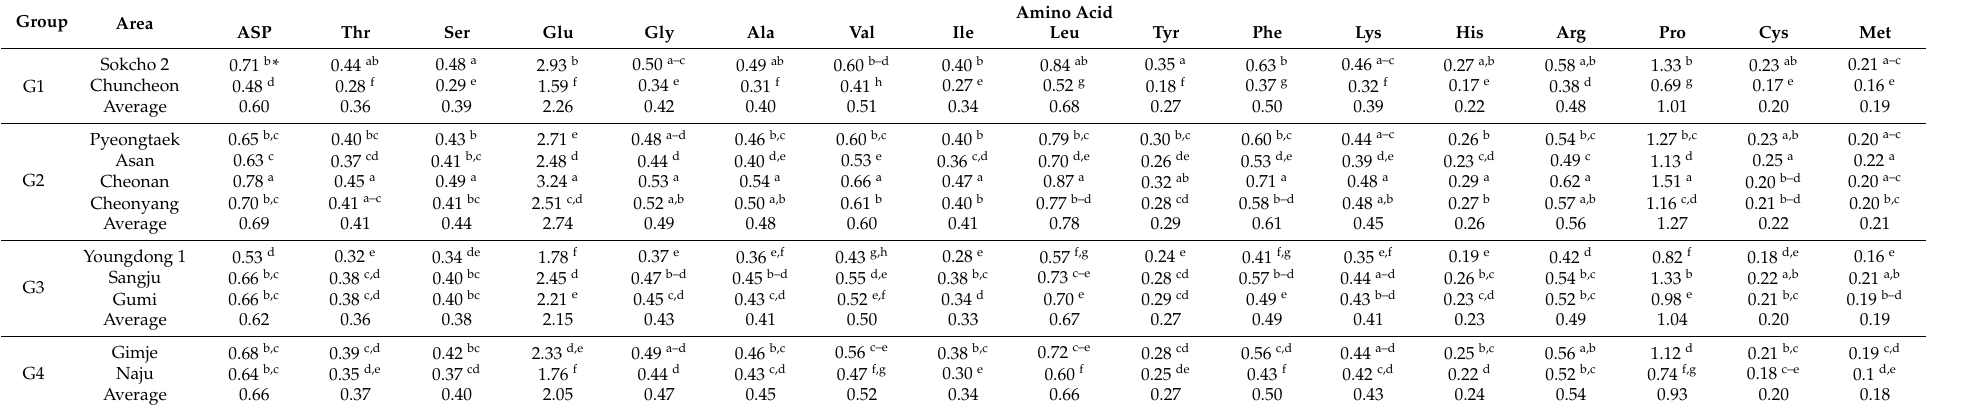
Table 8. Amino acid contents in dehulled barley seeds in different group areas in